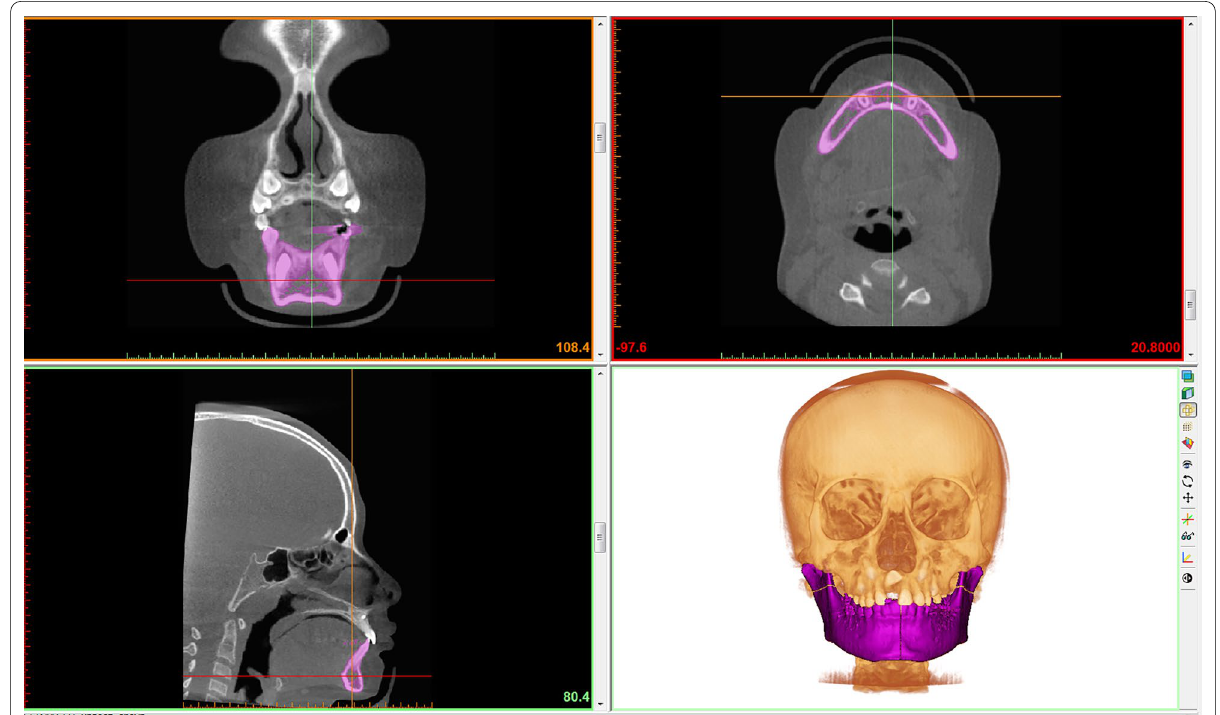
Fig. 2 Software view of the first step of mandibular segmentation, that is the definition of whole mandibular volume using Materialise ™ Mimics software